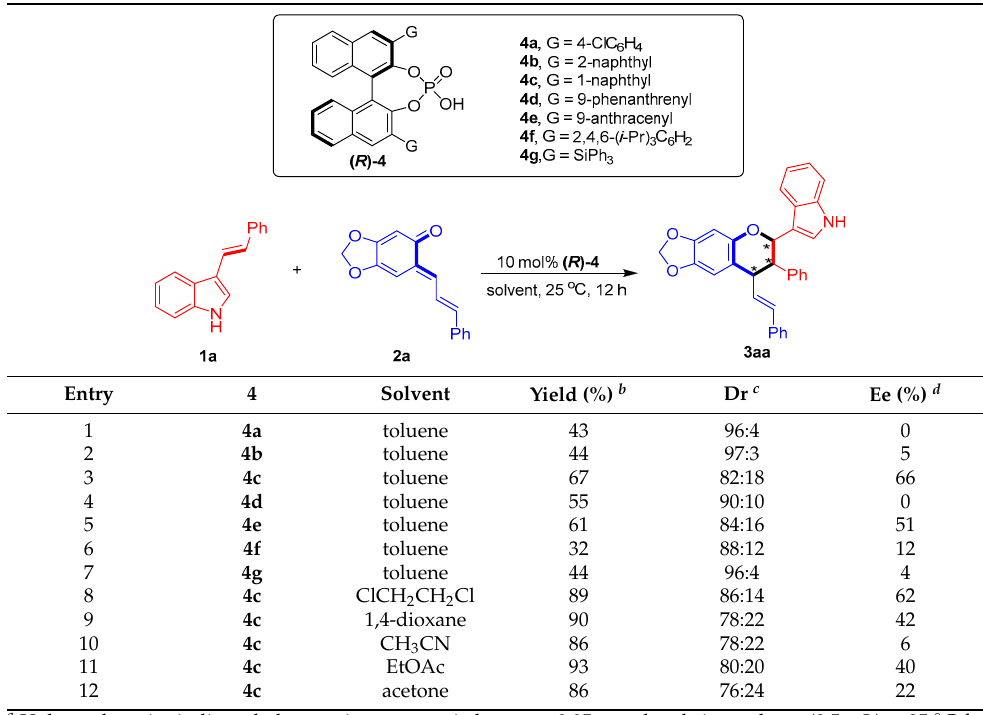
Table 1. Screening of catalysts and solvents a .